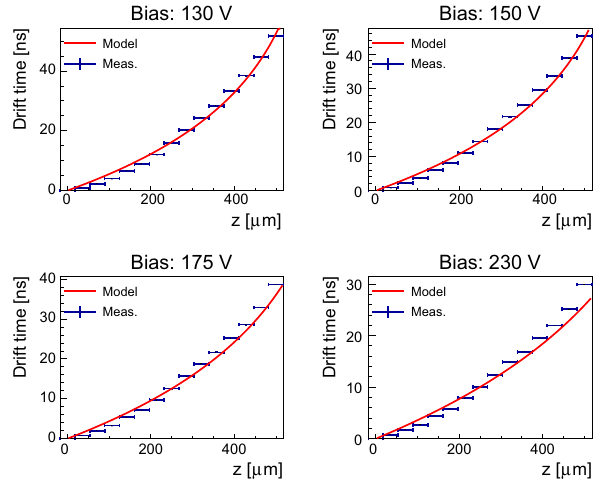
Fig. 6 Comparison of measured and drift times calculated according toEq.(5)withtheparametersgiveninTable1fordifferentbiasvoltages